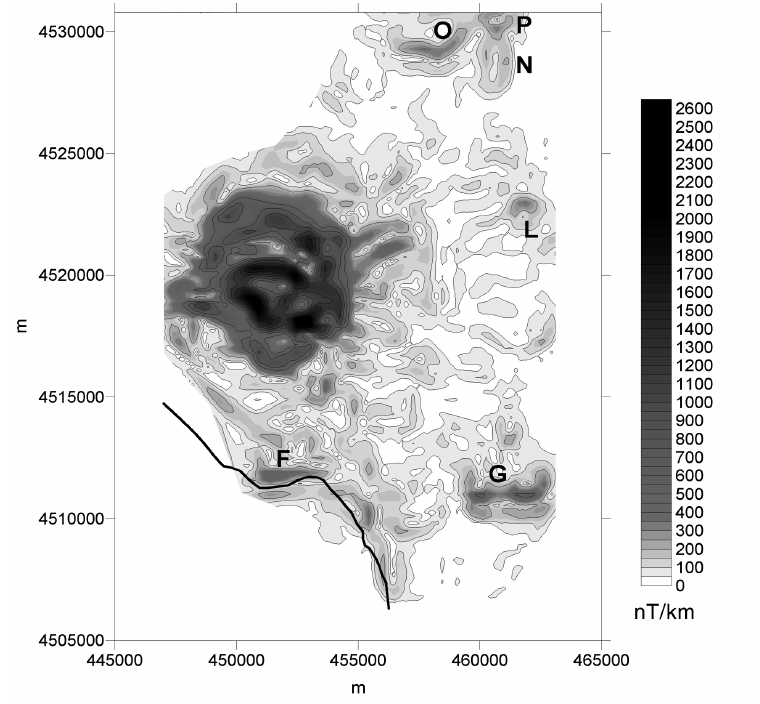
Fig. 8. Map of the Horizontal Derivative of the pole reduced magnetic field of the Vesuvian